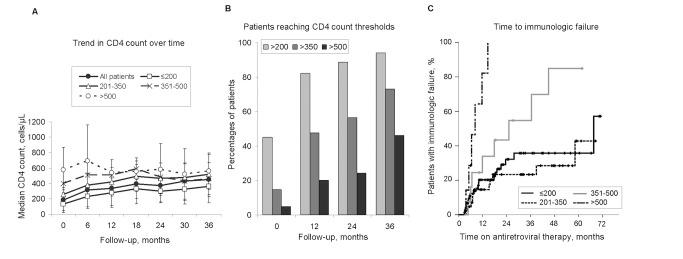
Immunological response to HAART during follow-up.Legend: A) Median increase in CD4+ T-cell count during the first 3 years of follow-up according to baseline CD4 T-cell count in the study population; dots represent median values over the study period by CD4 T-cell count baseline strata; bars represent interquartile range; B) Percentage of patients reaching clinically relevant thresholds of CD4 T-cell count (>200 cells/µL; >350 cells/µL; >500 cells/µL) during follow-up; C) Kaplan-Meier plots of the probability of immunologic failure according to baseline CD4 T-cell count (cells/µL) during follow-up.